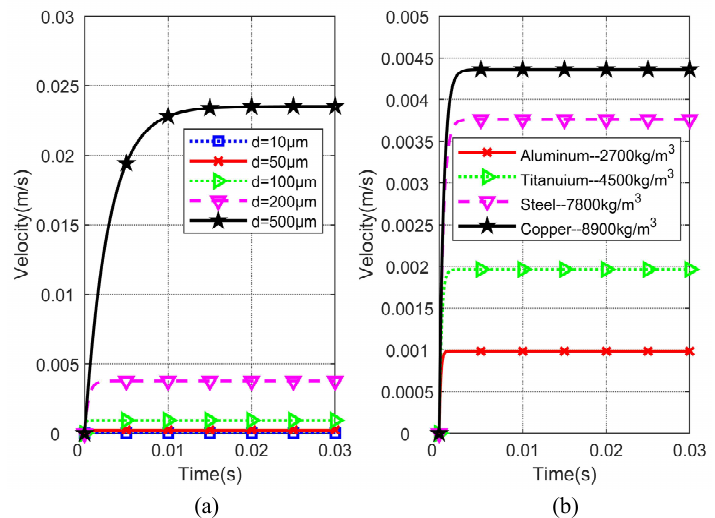
Figure 4. Velocities of particles with different properties moving in a vertical pipe: ( a ) iron particles of different diameters, ( b ) different density particles with a diameter of 200 μm.